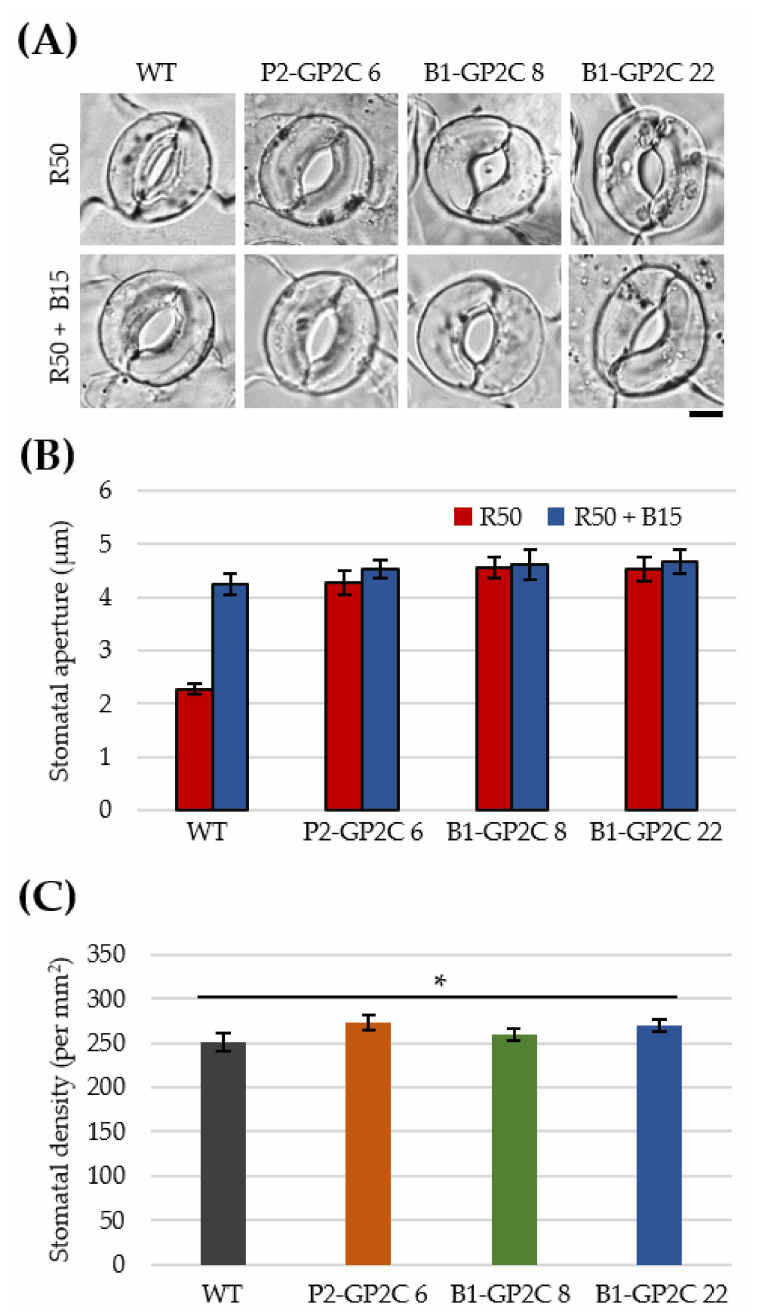
Figure 5. Stomatal apertures in P2-GP2C and B1-GP2C plants. ( A ) Confocal images showing the stomatal opening of the WT, P2-GP2C, and B1-GP2C plants. Epidermal strips were detached and preincubated for 1 h in darkness and then illuminated by red light (R50, 50 µ mol m − 2 s − 1 ) with or without blue light (B15, 15 µ mol m − 2 s − 1 ) for 3 h. Scale bar = 5 µ m. ( B ) Stomatal apertures in the WT, P2-GP2C, and B1-GP2C plants under the same conditions as A. Data represent the mean ± SE ( n = 20). ( C ) Stomatal density of 4-week-old plants. Data represent the mean ± SE ( n = 10 independent leaves). Asterisk indicates statistical difference detected by Student’s t test (* not significant p >